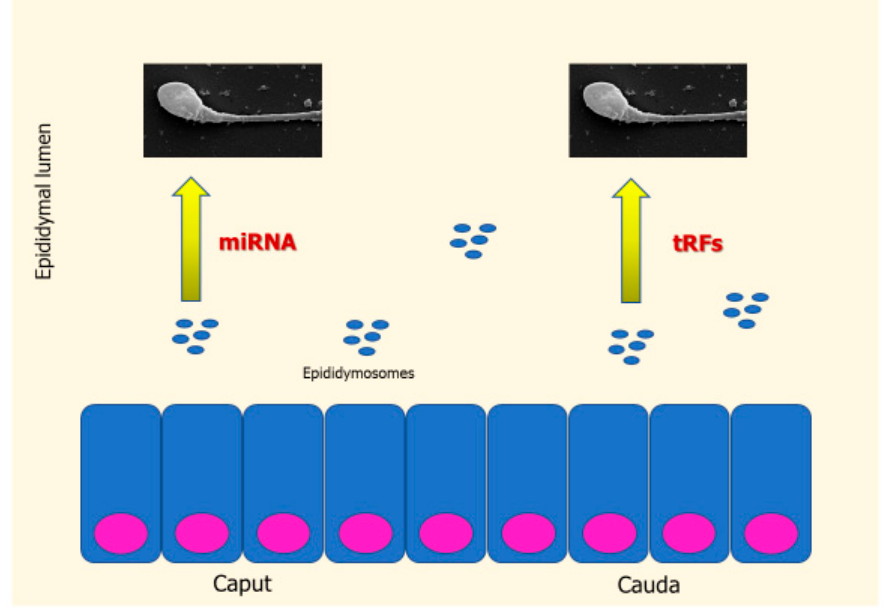
Figure 1. RNA exchange between epididymosomes and sperm in the epididymal lumen. In the caput epididymis, spermatozoa are enriched of miRNAs; in the cauda, they are enriched of RNA-derived fragments (tRFs). Rectangles indicate cells of epididymal epithelium. Blue circles indicate epididymosomes.